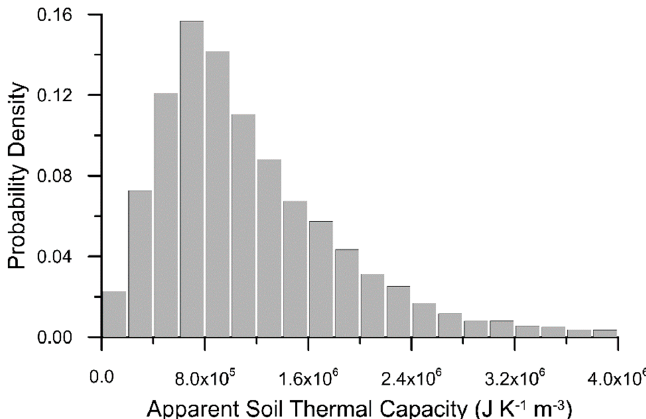
Figure 7. Probability density of soil Apparent Thermal Capacity for TVGr .